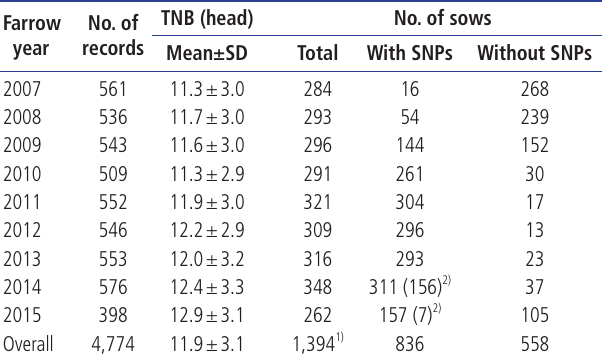
Table 6. Means and standard deviations for the total number of piglets born (TNB) by selection ratio and the estimation method Total number of piglets born (TNB) No. of Top % sows